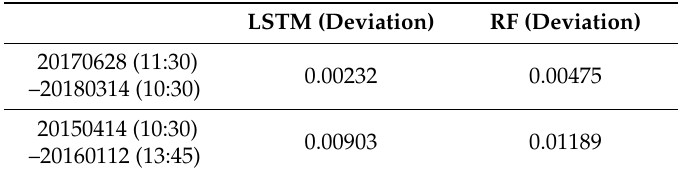
Table 5. Comparison table of deviation values predicted by the LSTM model and the LSTM-SVR model over two time periods.